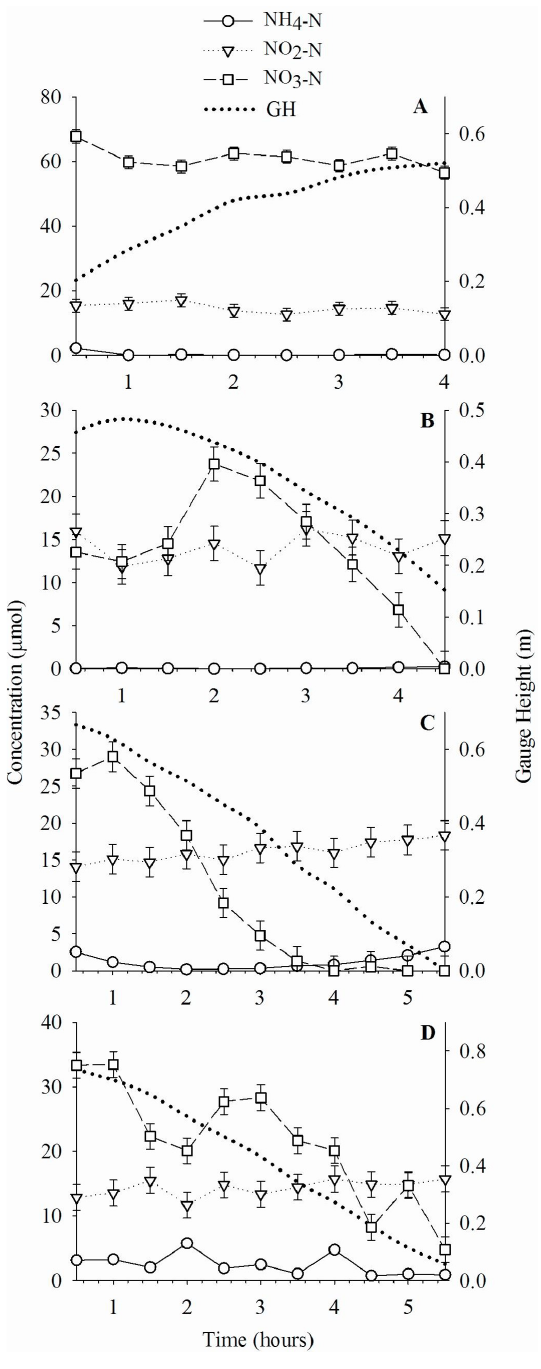
Fig. 2. Examples of water chemistry measurements. (A) Constant concentrations on incoming tides at Site 1 on 24 September 2008. (B) Nitrogen concentrations and tidal stage for the ebbing tidal cy- cle at Site 1 on 20 September 2008. The nitrate concentrations de- crease with the dropping tidal stage. (C) Data for the ebbing tide at Site 2 on 1 October 2008. (D) Data for the ebbing tide at Site 3 on 1 October